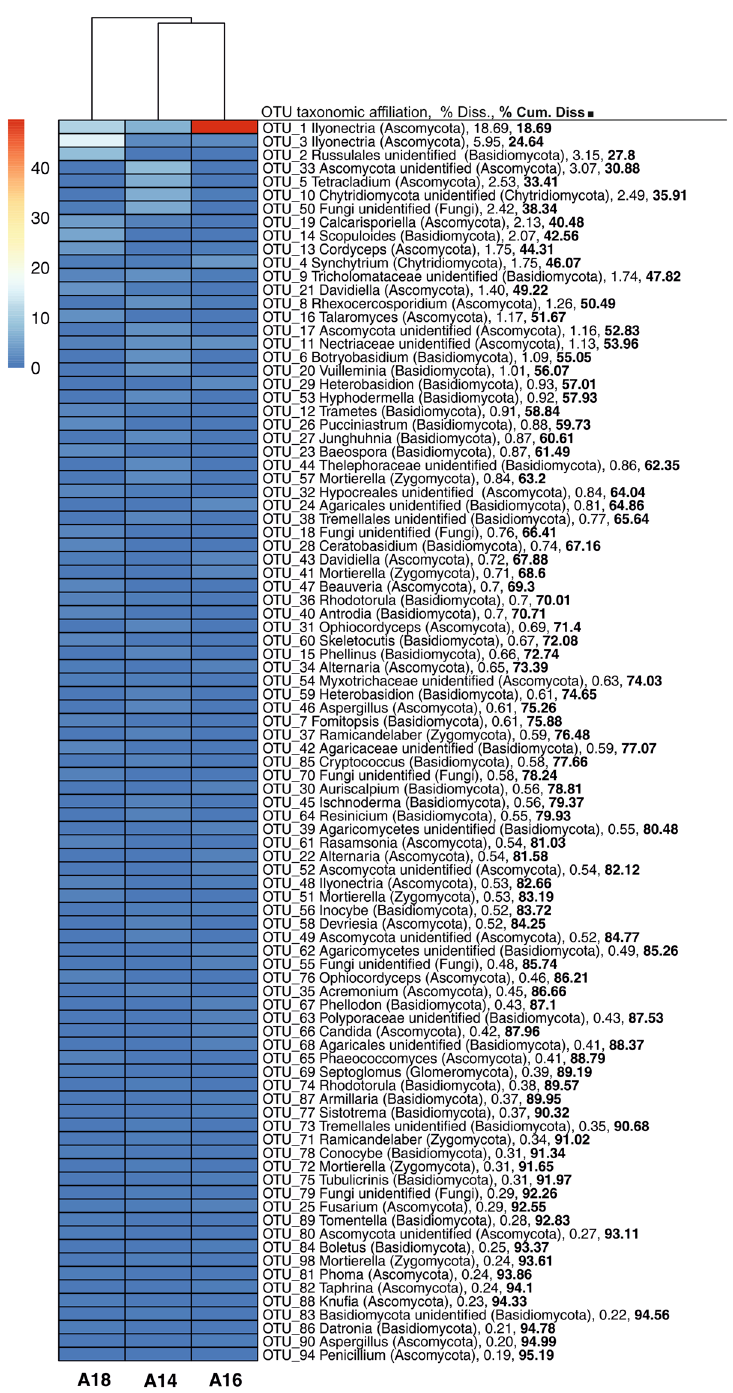
Figure 5. Heat map showing the relative abundance of top fungal OTUs contributing to differences (SIMPER analysis) in fungal community structures among the studied layers A14 (upper), A16 (intermediate) and A18 (lower). Only OTUs contributing ≥ 0.2% of dissimilarity among layers were selected for heat map representation and they were represented in decreased order of dissimilarity contribution. Sites were clustered using UPGMA dendrogram based on Canberra distances. Percentages to the right of each OTU indicate the percent dissimilarity contributed by each OTU (% Diss.) and the cumulative percent dissimilarity among layers (% Cum. Diss.). Color legend and scale (%) are provided in the